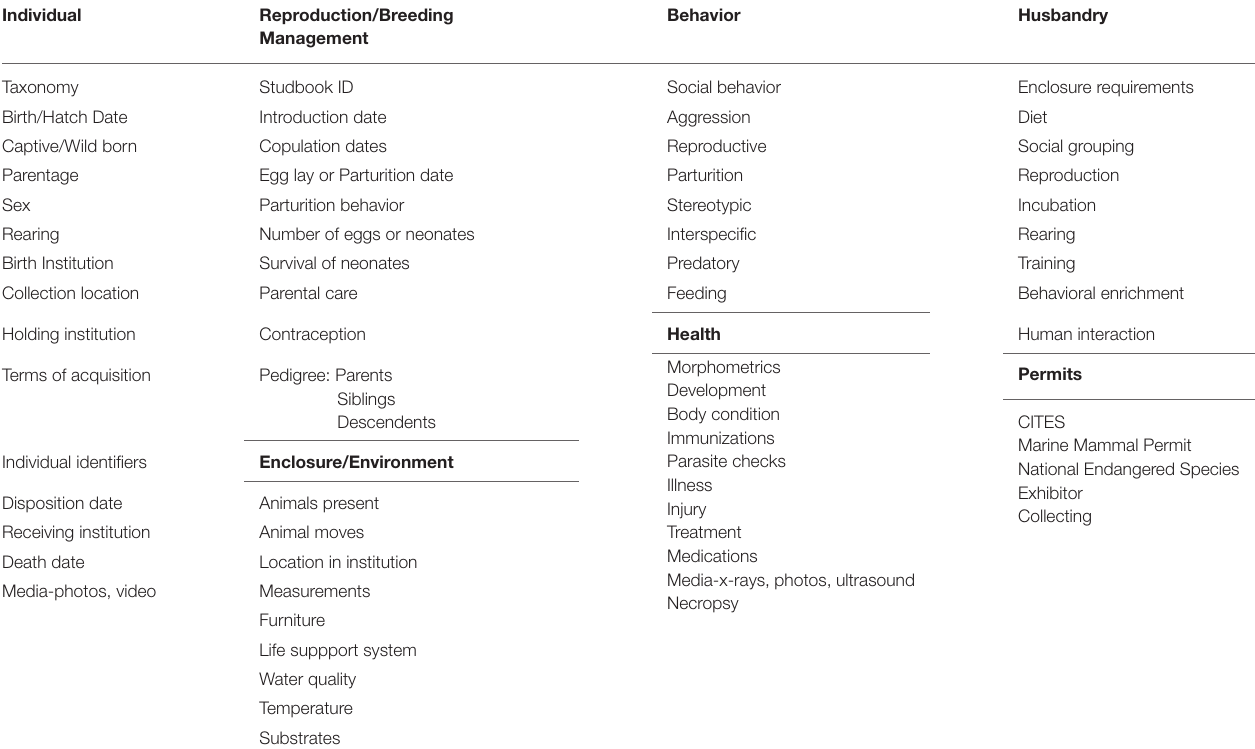
TABLE 1 | Core data for individual specimen records in ZIMS.